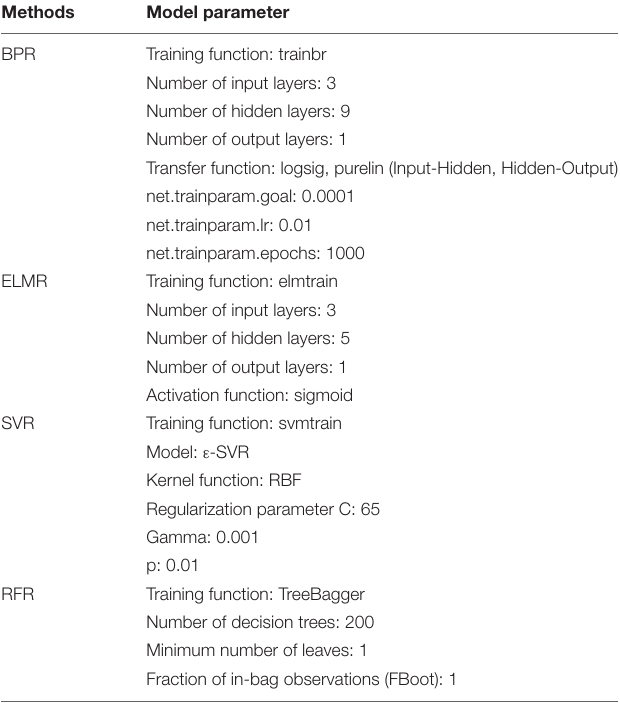
TABLE 3 | Machine learning model parameters.